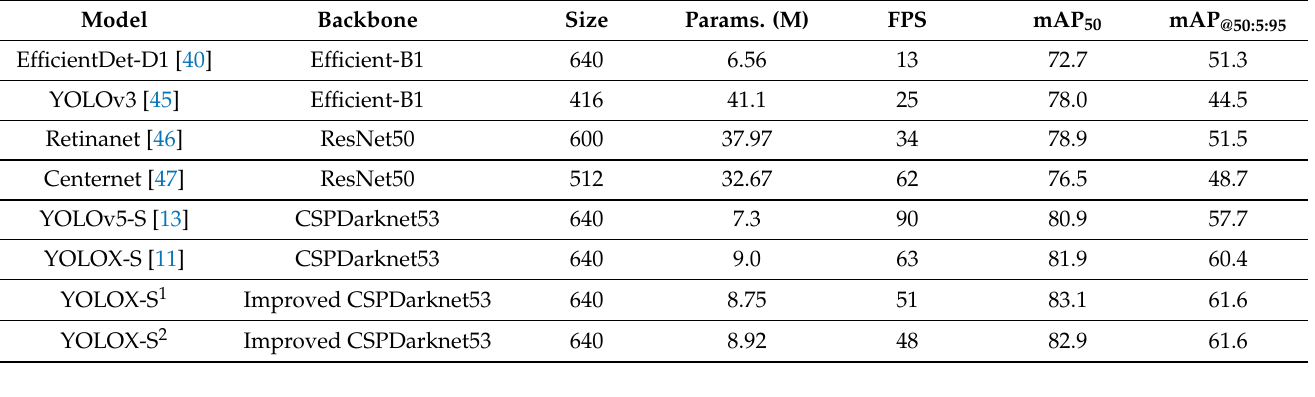
Table 5. Experimental results of each algorithm on the PASCAL VOC 2007 test dataset.